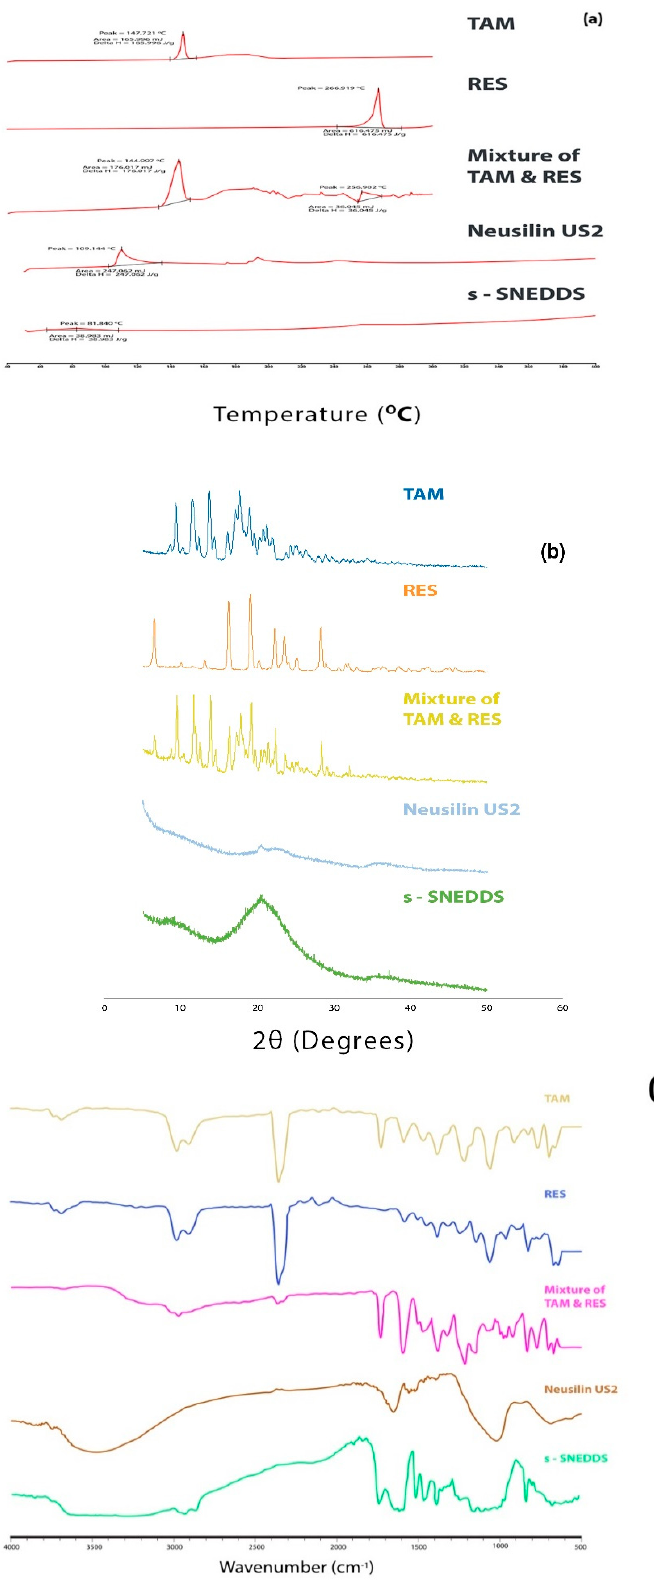
Figure 6. ( a ) DSC curve, ( b ) XRD graph, ( c ) FTIR spectra of TAM, RES Mixture of TAM and RES, Neusilin US2 and s-SNEDDS.